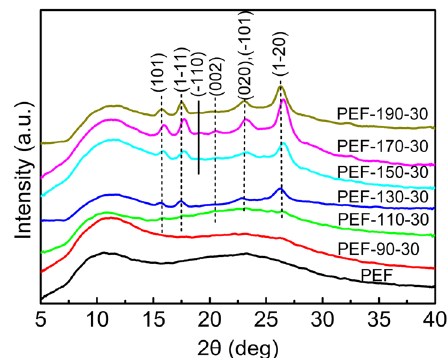
Figure 1: XRD patterns of PEF - T -